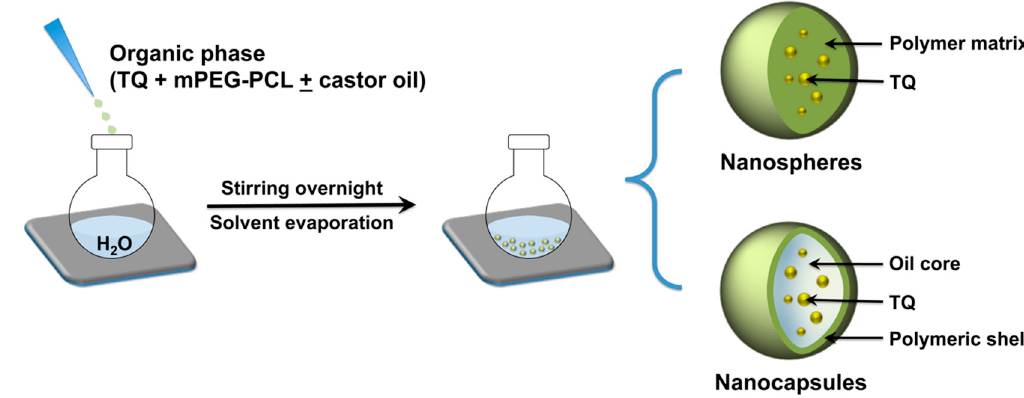
Figure 1. Overview of TQ NP fabrication by nanoprecipitation using mPEG-PCL. Different formulations were prepared by varying the MW of the PCL block with or without the addition of castor oil to the organic phase, which resulted in the formation of matrix-like nanospheres (NS) or reservoir-type nanocapsules (NC) with an oil-filled core and a polymeric shell.